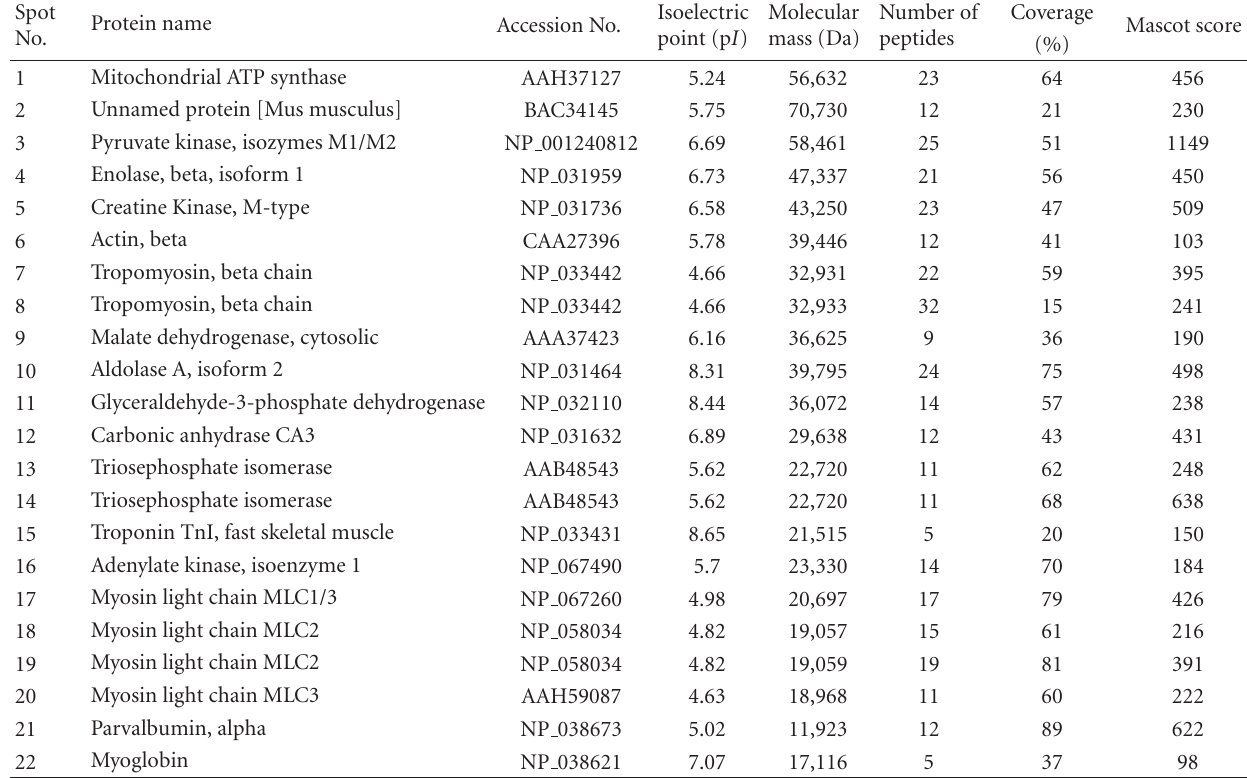
Table 1: List of unchanged landmark 2D protein spots from normal mouse tibialis anterior muscle.